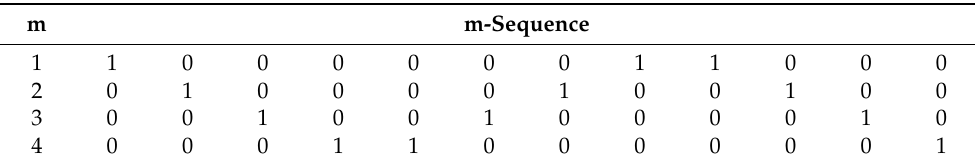
Table 1 represents an example of 1D-MD code for w = 3, K = 4 and L = 12 [11]. Table 1. 1D-MD code sequence for w = 3, K = 4 and L =